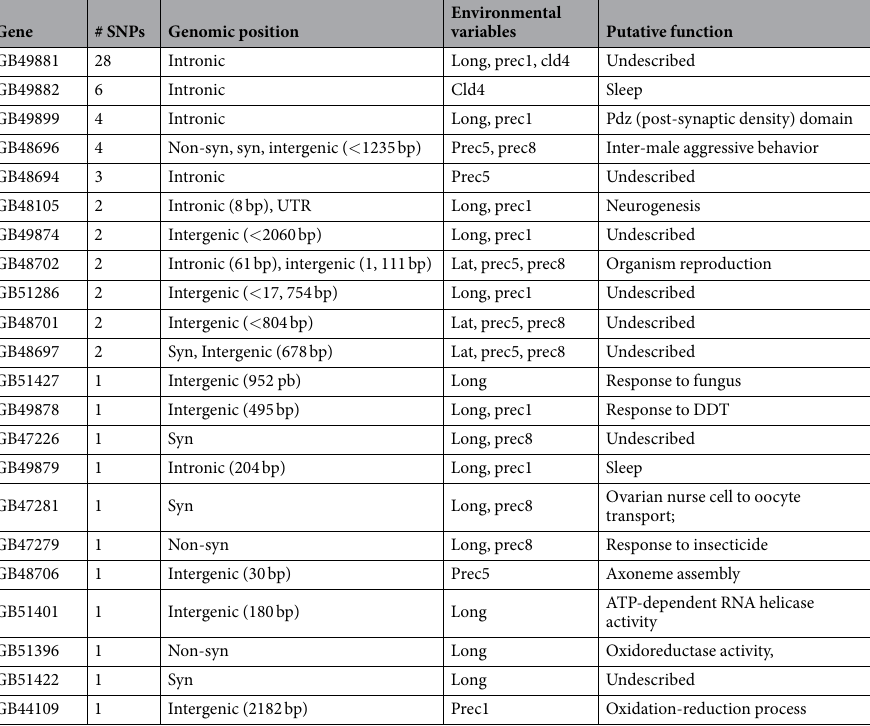
Table 3. Genomic information, and associated environmental variables, of candidate genes cross-detected by Sam β ada, LFMM, PCAdapt and |iHs| > 2. Putative functions were summarized from FLYBASE. The correlated environmental variables are longitude (long); cloud cover in April (cld4); precipitation in January (prec1), May (prec5) and August